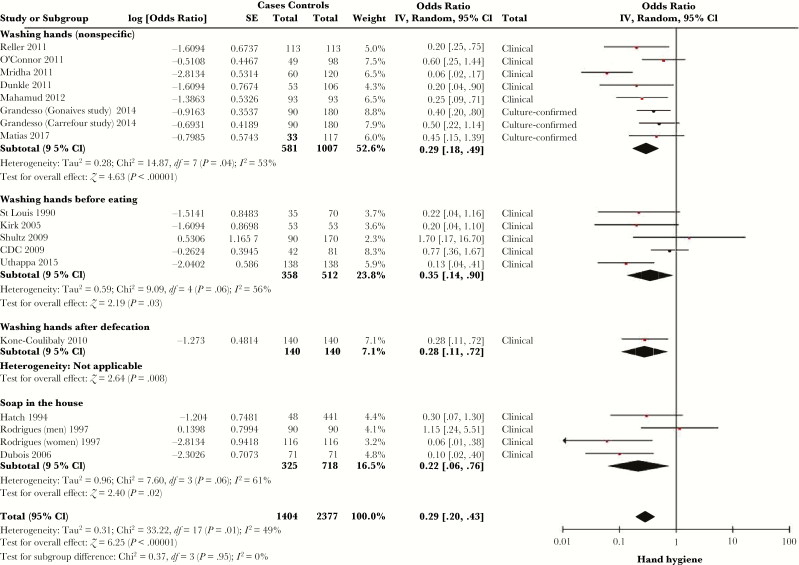
Forest plot of studies included in meta-analysis assessing whether handwashing was associated with symptomatic cholera. Studies were stratified by whether they assessed handwashing before eating, nonspecific handwashing, or presence of soap in the household. The summary odds ratio was calculated using random effects models. Heterogeneity is described using the Cochran Q test and the I2 statistic. Abbreviations: CI, confidence interval; df, degrees of freedom; IV, inverse variance; SE, standard error.